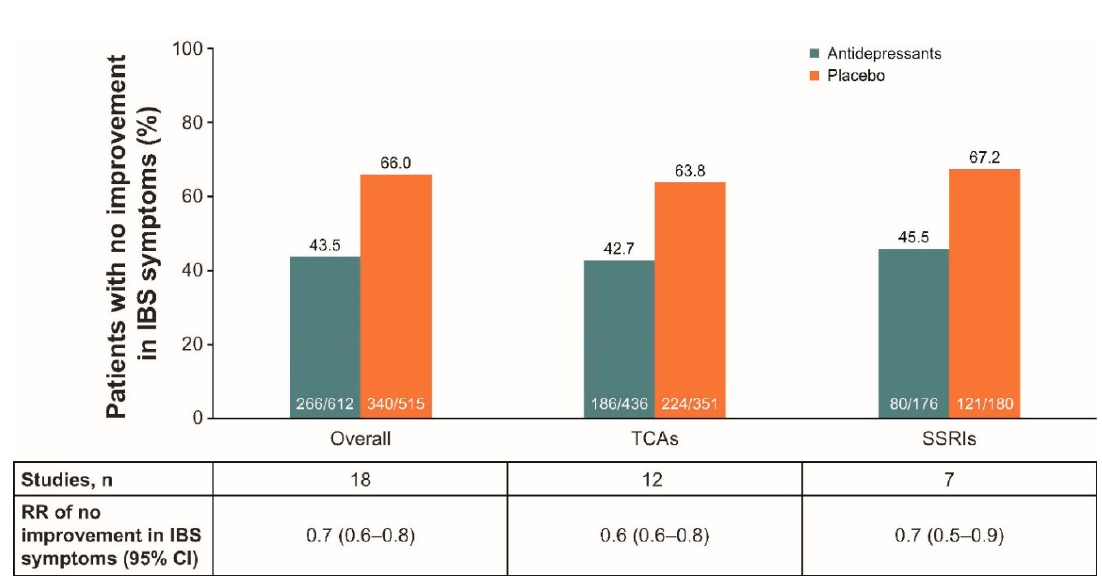
Figure 1. Efficacy of antidepressants for the treatment of IBS [12]. CI: confidence interval, IBS: irritable bowel syndrome, RR: relative risk, SSRI: selective serotonin reuptake inhibitor, TCA: tricyclic antidepressant.